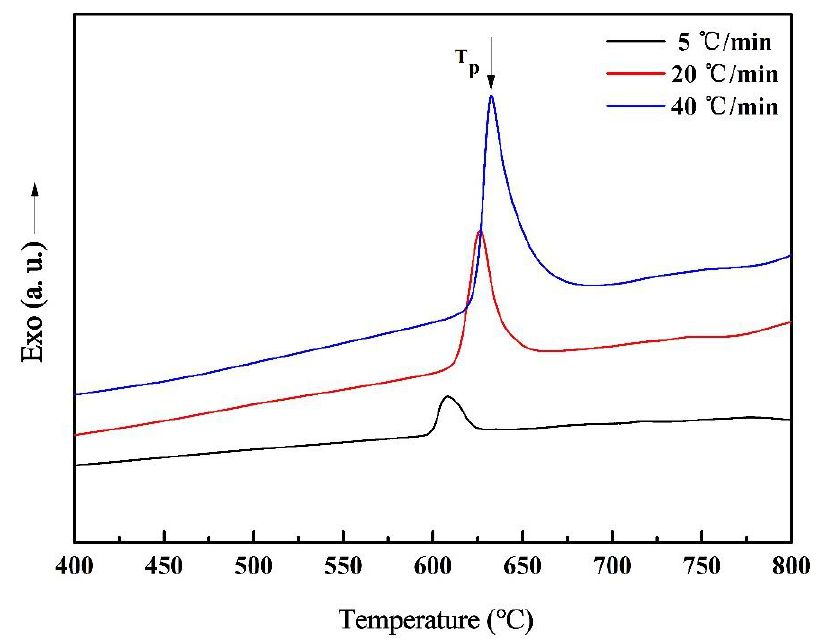
Figure 2. DSC curves of the (Nd 0.525 Pr 0.175 Ce 0.3 ) 9 Fe 64.5 Co 3 Cu 0.5 Ti 1 B 22 as-spun ribbons.